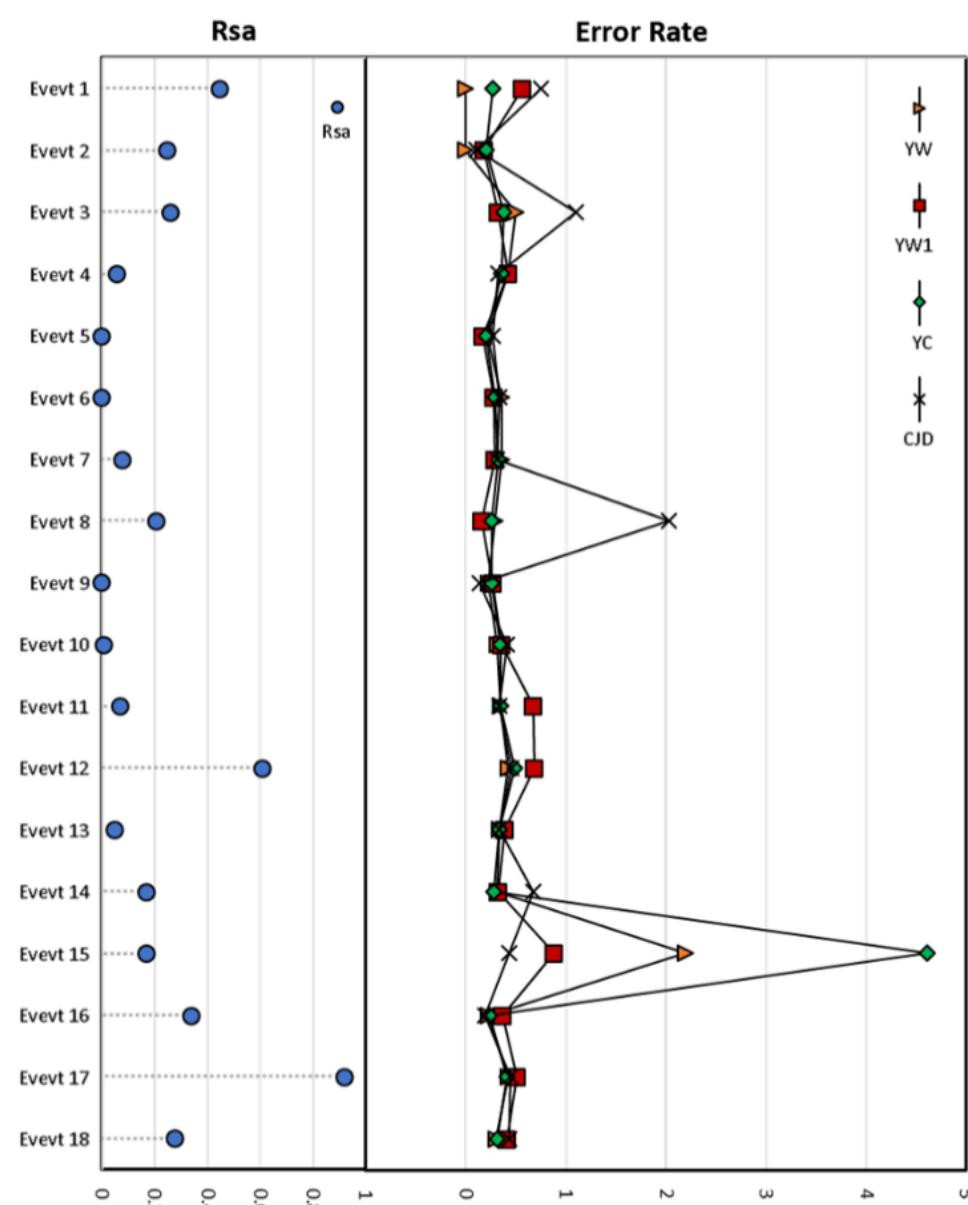
Figure 5. Cumulative saturated rainfall ( R sa ) and error rates of streamflow data propagation at each gauge station (YW: Youngwol, YW1: Youngwol 1, YC: Youngchun, and CJD: Chungju Dam). Events’ details displayed in Table 1.